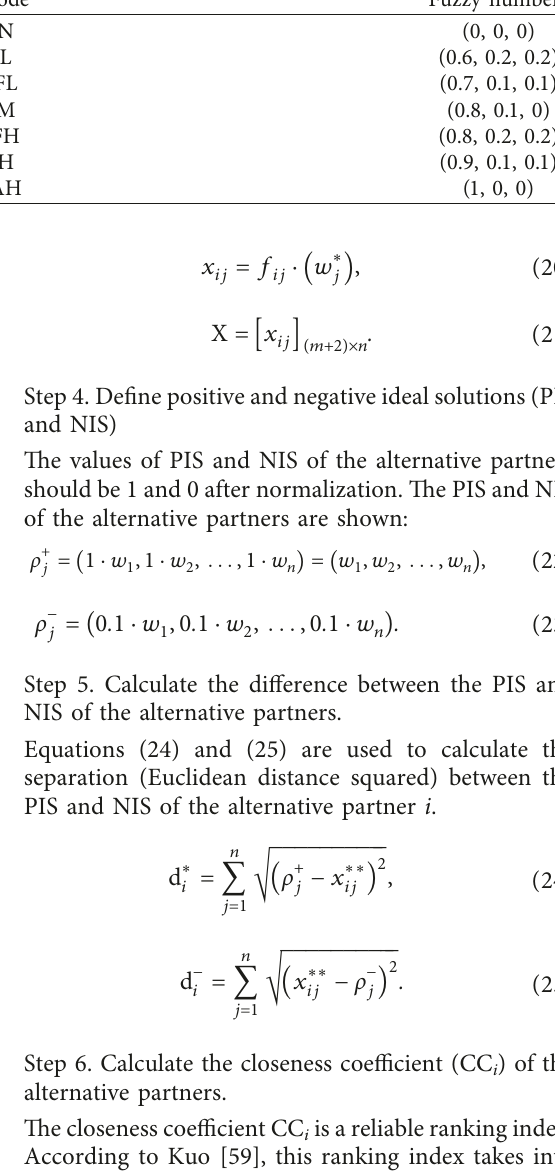
Table 8: Linguistic variables and corresponding fuzzy numbers in the neutrosophic part [58]. Linguistic